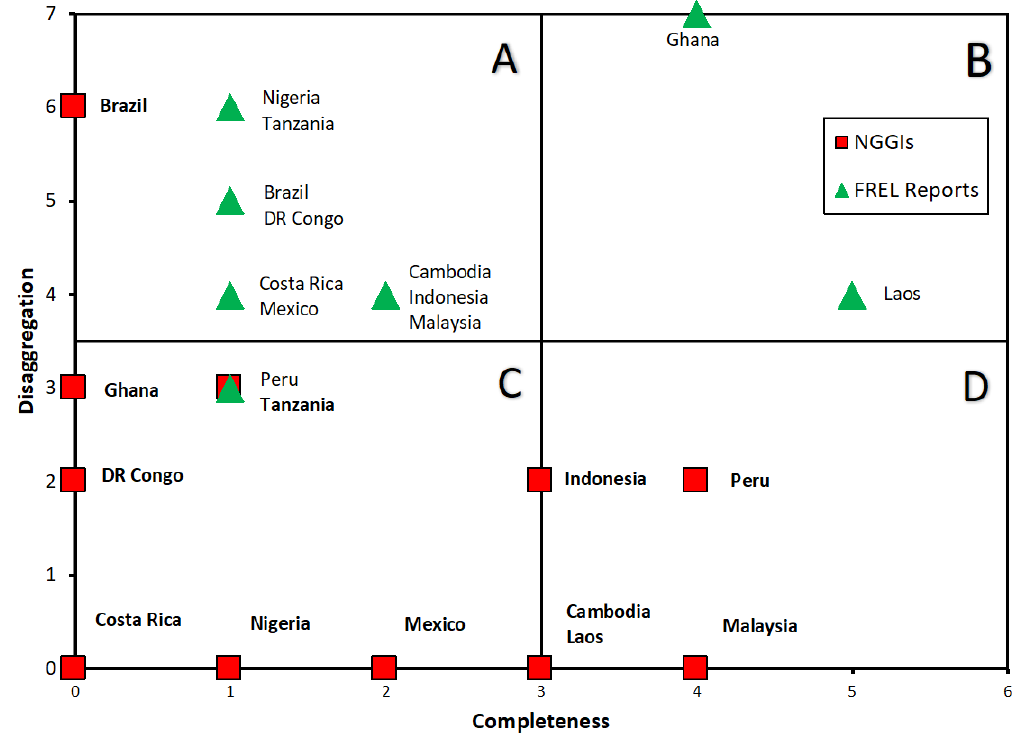
Figure 10. A trade-off box for disaggregation and completeness in estimates in National Greenhouse Gas Inventories (NGGIs) and Forest Reference Emission Level (FREL) reports for twelve tropical countries [54–77]. countries